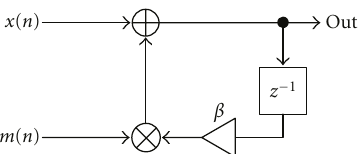
Figure 18: FBAM variation 6 with decoupled input signals.